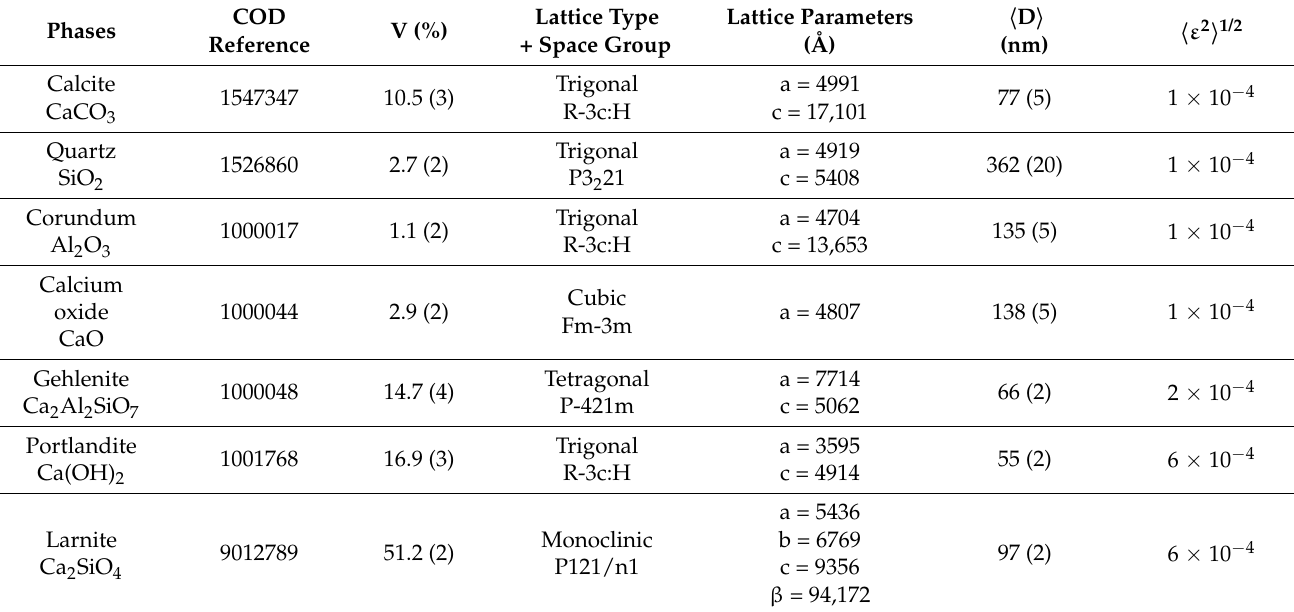
Figure 1. X-ray diffraction diagram of FA. The calculated diagram (red color) is superimposed onto the experimental profile (black color). At the bottom, we present the difference curve (I exp –I calc ). Table 3. The Mineralogical Composition of FA.